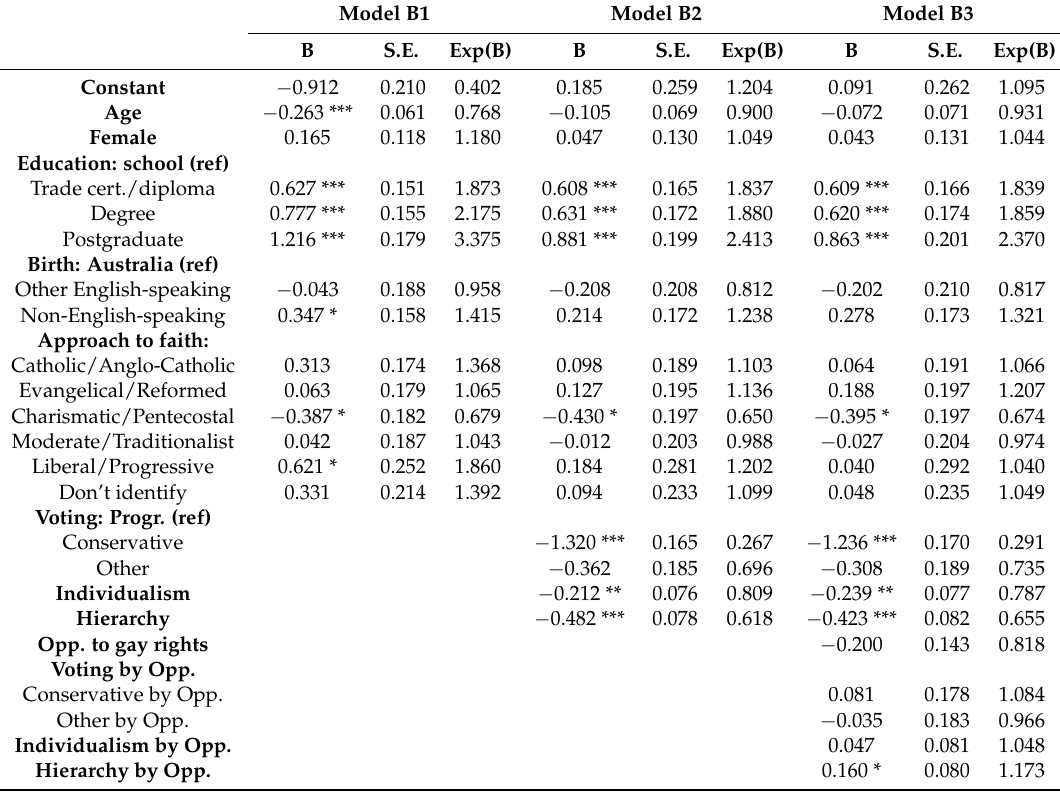
Table 6. Prediction of belief in anthropogenic climate change beliefs from demographics, approaches to faith, and political